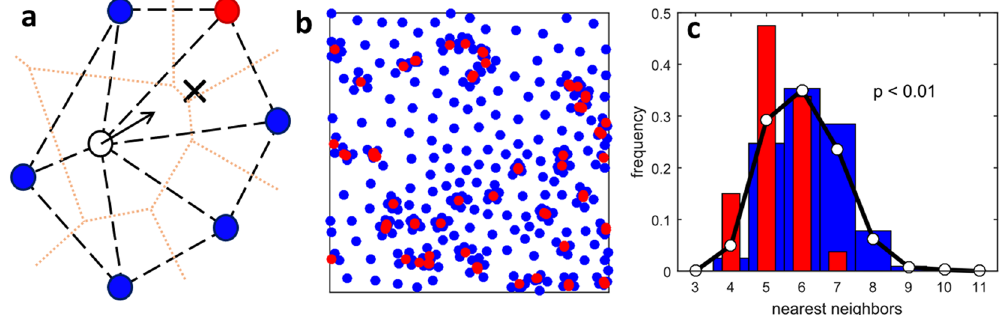
Figure 1. Hierarchical interaction between individuals with a weight ratio ρ = 0.2. ( a ) An individual (open circle) surrounded by high-ranking (red) and low-ranking (blue) nearest neighboring males moves towards their center of mass (cross). Here the weight of the high ranking male is 5 times larger than that of low ranking ones. The dotted line identifies the edges of territories defined as the region of space closer to the territory owner than to any other individual. Nearest neighbor individuals are those that share a boundary of their territories. ( b ) Stable spatial configuration of high-ranking (red) and low-ranking (blue) males obtained for φ = 0.8 and ρ = 0.2. In the initial configuration, individuals were randomly distributed. The final stable configuration shows the formation of clusters of low-rank individuals around high-rank ones. Each of these clusters represents a lek. ( c ) Histograms of the distribution of the number of nearest neighbors for high-ranking males (red), low- ranking males (blue), and the overall population (white dots); the histograms correspond to the configuration shown in panel